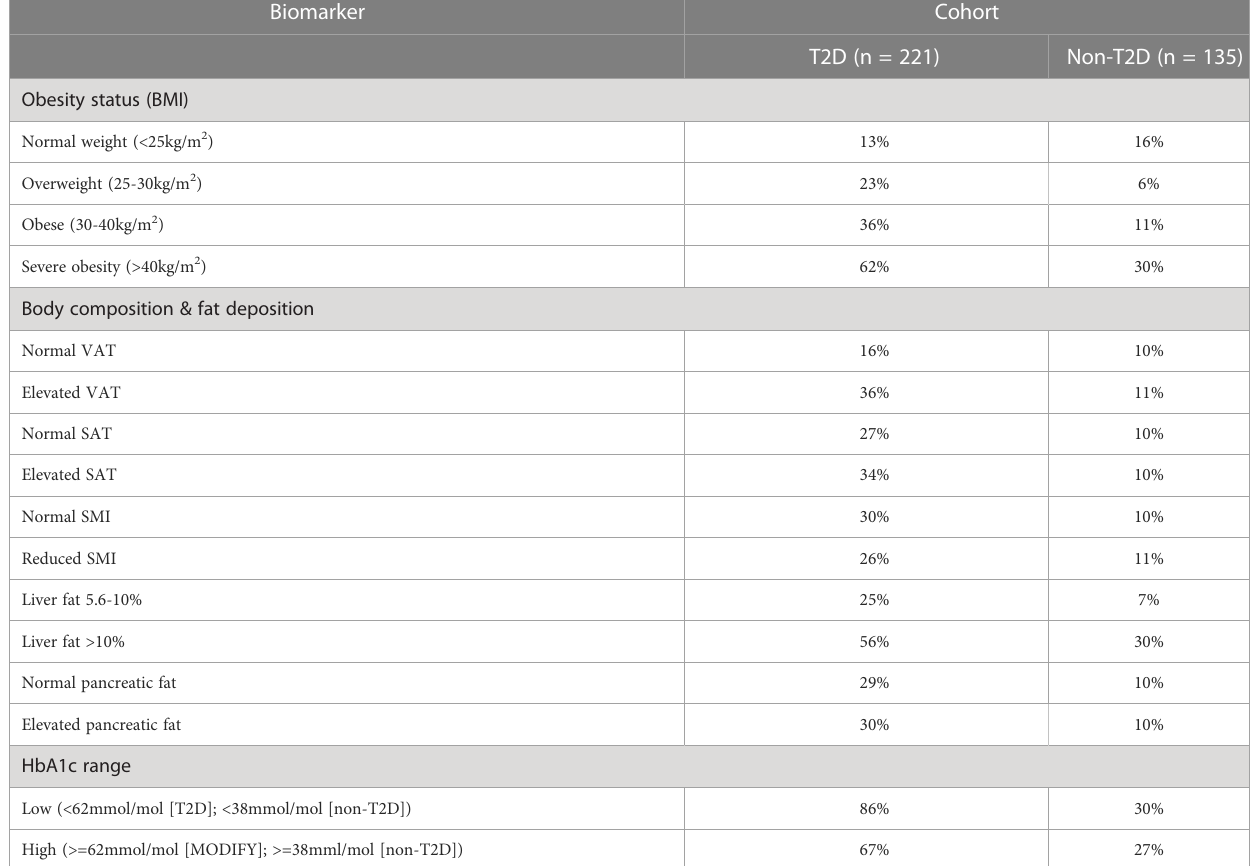
TABLE 2 Probability of NASH (%) under different variable settings in the T2D and non-T2D cohorts.